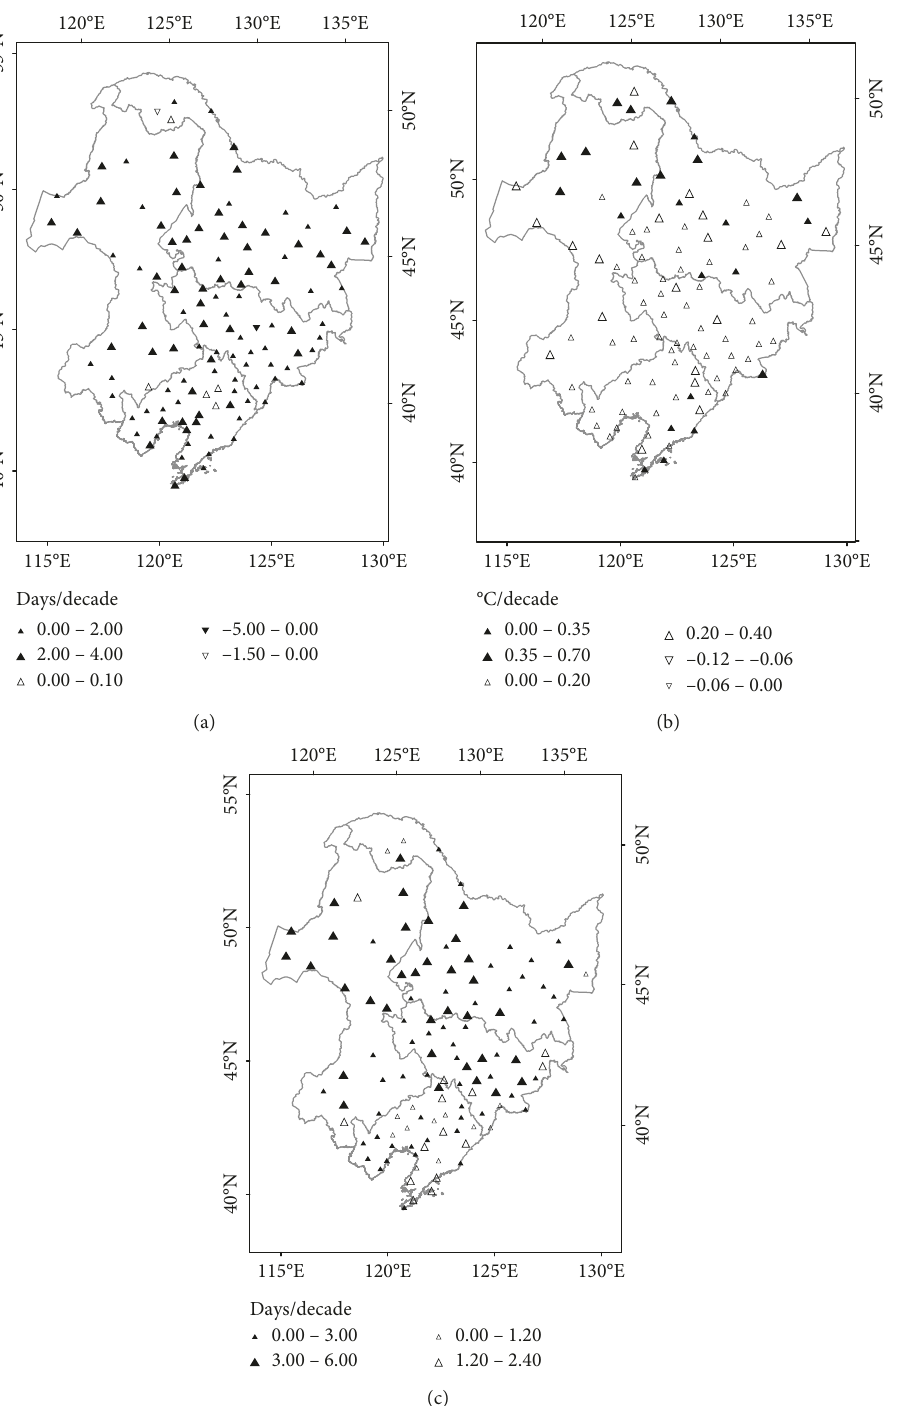
Figure 4: Spatial distributions of trends per decade for the period of 1957–2015 in Northeast China for extremely warm temperature indices (TN90p (a), TXx (b), and GSL (c)). The up and down triangles represent positive and negative trends, respectively. The filled triangles indicate that the trend is significant at 95% confidence level, and vice versa. The size of the triangle is equivalent to the magnitude of the